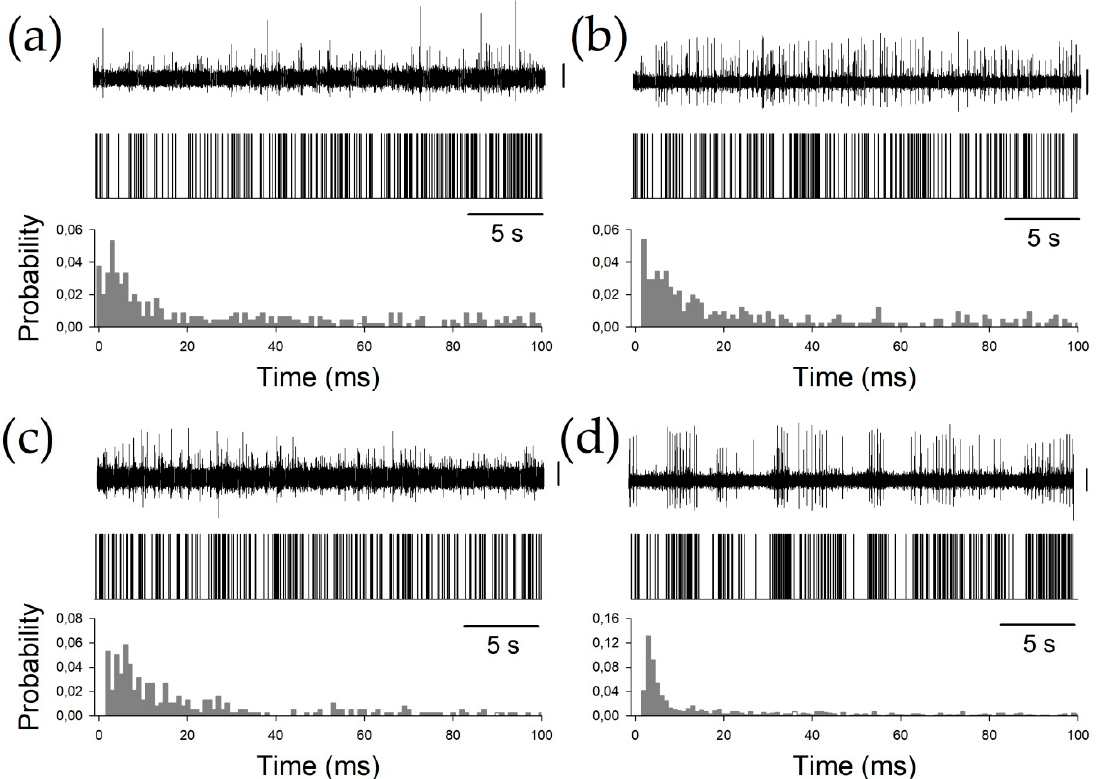
Figure 3. Examples of all the nuclei. ( a ) Ce.pc, ( b ) Ce.mc ( c ) V.c, and ( d ) V.im. For every panel, the upper row shows the raw trace obtained by the microelectrode recording (MER), the middle row shows the binary plots, and the bottom row shows the probability density functions (pdfs). Vertical calibration bars = 50 µV.